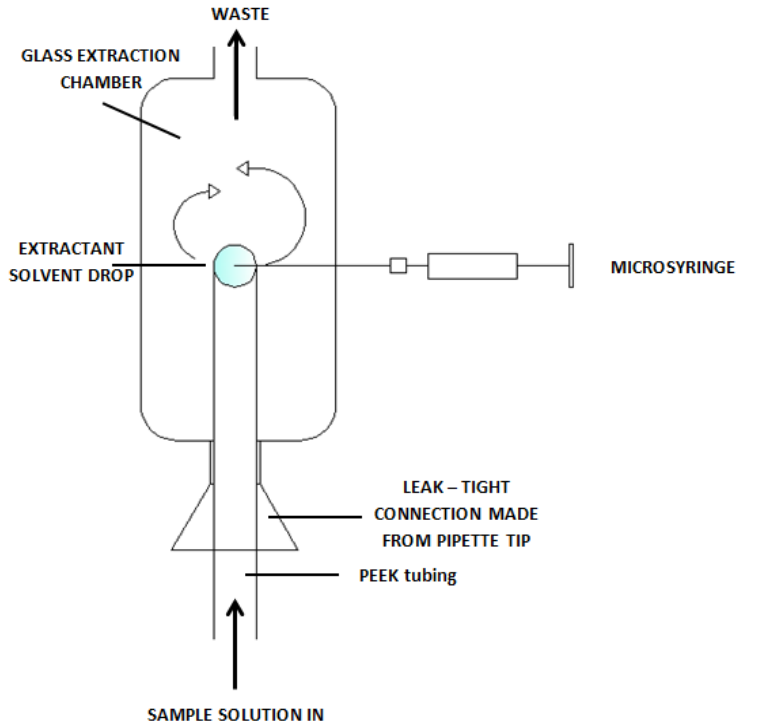
Figure 5. A diagram of a set for continuous flow microextraction